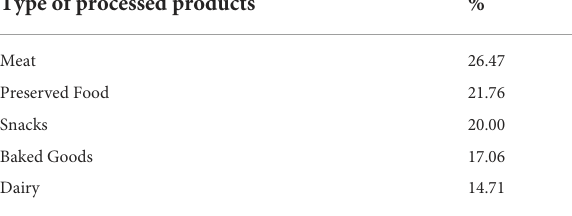
TABLE 2 Processed products in